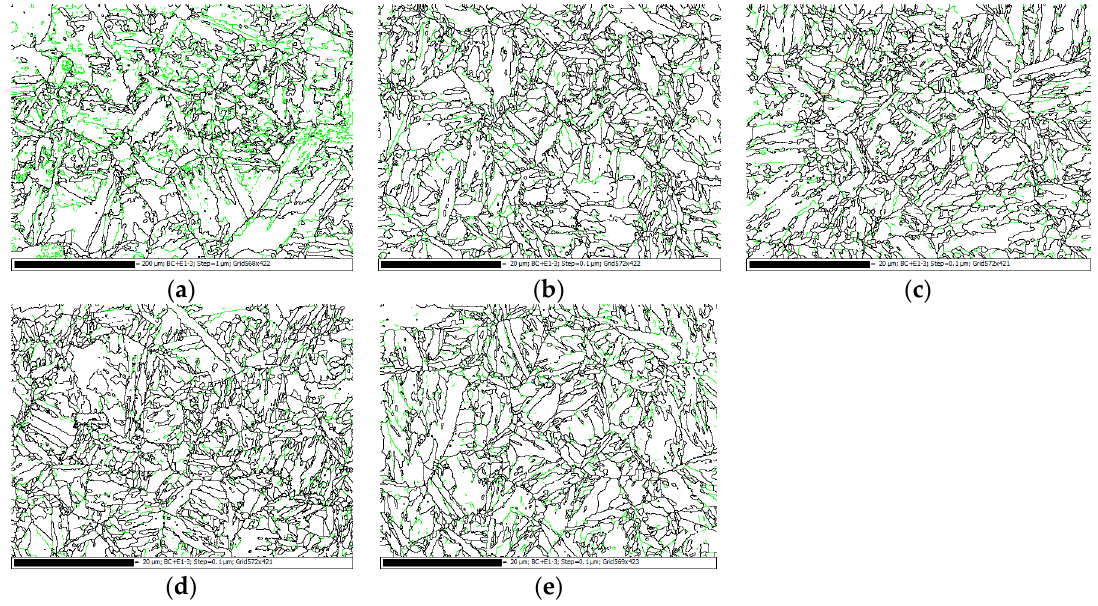
Figure 11. The grain boundary maps for ( a ) BM, ( b ) HD-L, ( c ) HD-T, ( d ) CF-L, and ( e ) CF-T.